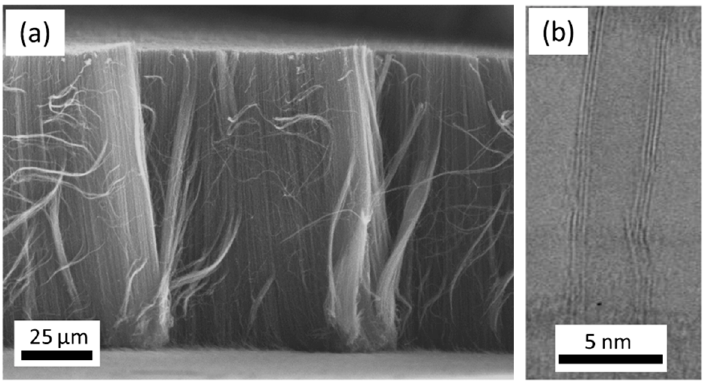
Figure 12. ( a ) Side-view SEM micrographs of VACNT achieved on TiSiN with 0.4 nm Fe/0.1 nm Al at 600 °C; ( b ) HRTEM image of recovered CNT sample; Reprinted with permission from Yang, Applied Physics Letters; Ref. [90] copyright 2015, AIP Publishing.